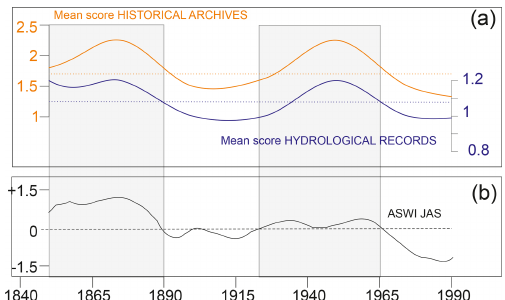
Figure 2. Observed and reconstructed rainfall anomalies over the Sahel during the 1840–1990CE period. (a) The mean scores from historical (yellow curve) and natural archives (blue curve) for the Sahel (Nicholson, 1978, 1980, 2013; Nicholson et al., 2012; Coquery-Vidrovitch, 1997; Holmes et al., 1999; Street-Perrott et al., 2000; Waller et al., 2007; Wang et al., 2008; Mulitza et al., 2010; Maley and Vernet, 2013; Lézine et al., 2019). The dotted yel- low and blue lines correspond, respectively, to the historical and paleo-hydrological archive mean scores during the period 1850– 1990CE. They allow identifying anomalously wet and dry periods. (b) The African Southwesterly Index (ASWI) developed by Gallego et al. (2015) as a measure of rainfall anomalies in Sahel during the WAM rainy season (July to